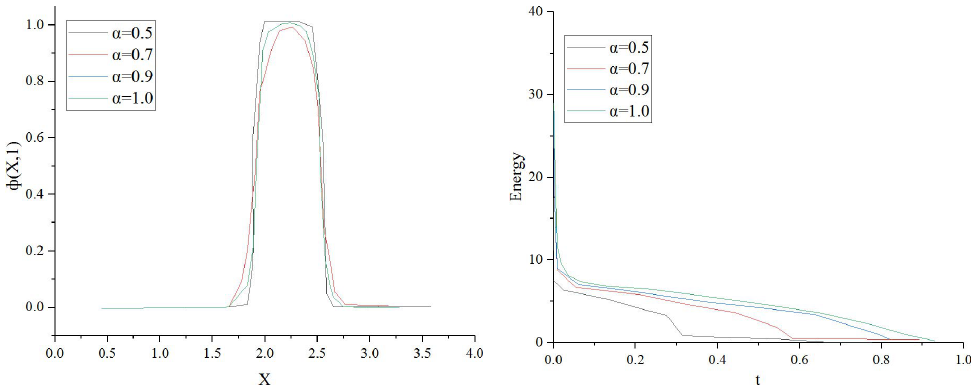
Fig. 3 Phase function of two-dimensional time-fractional Allen-Calm equation and change of energy with time 3 Cranknicolson-Galerkin finite element algorithm for higher-order fractional parabolic